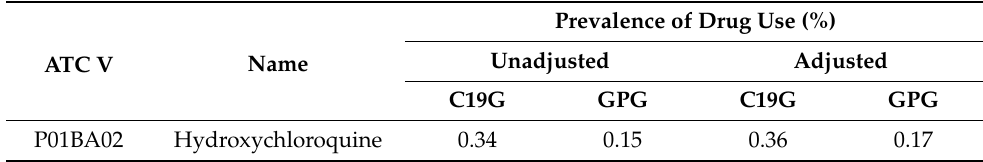
Table 2. Differences in prevalence of hydroxychloroquine use between C19G and GPG.